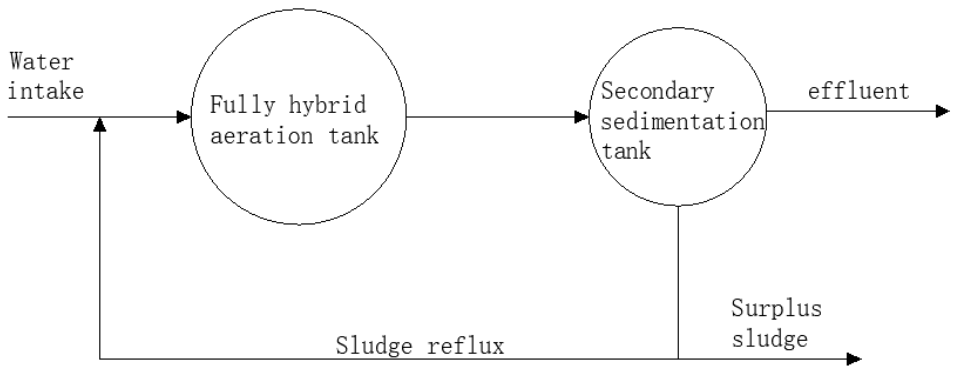
Figure 2. Process flow chart of completely mixed aeration tank.